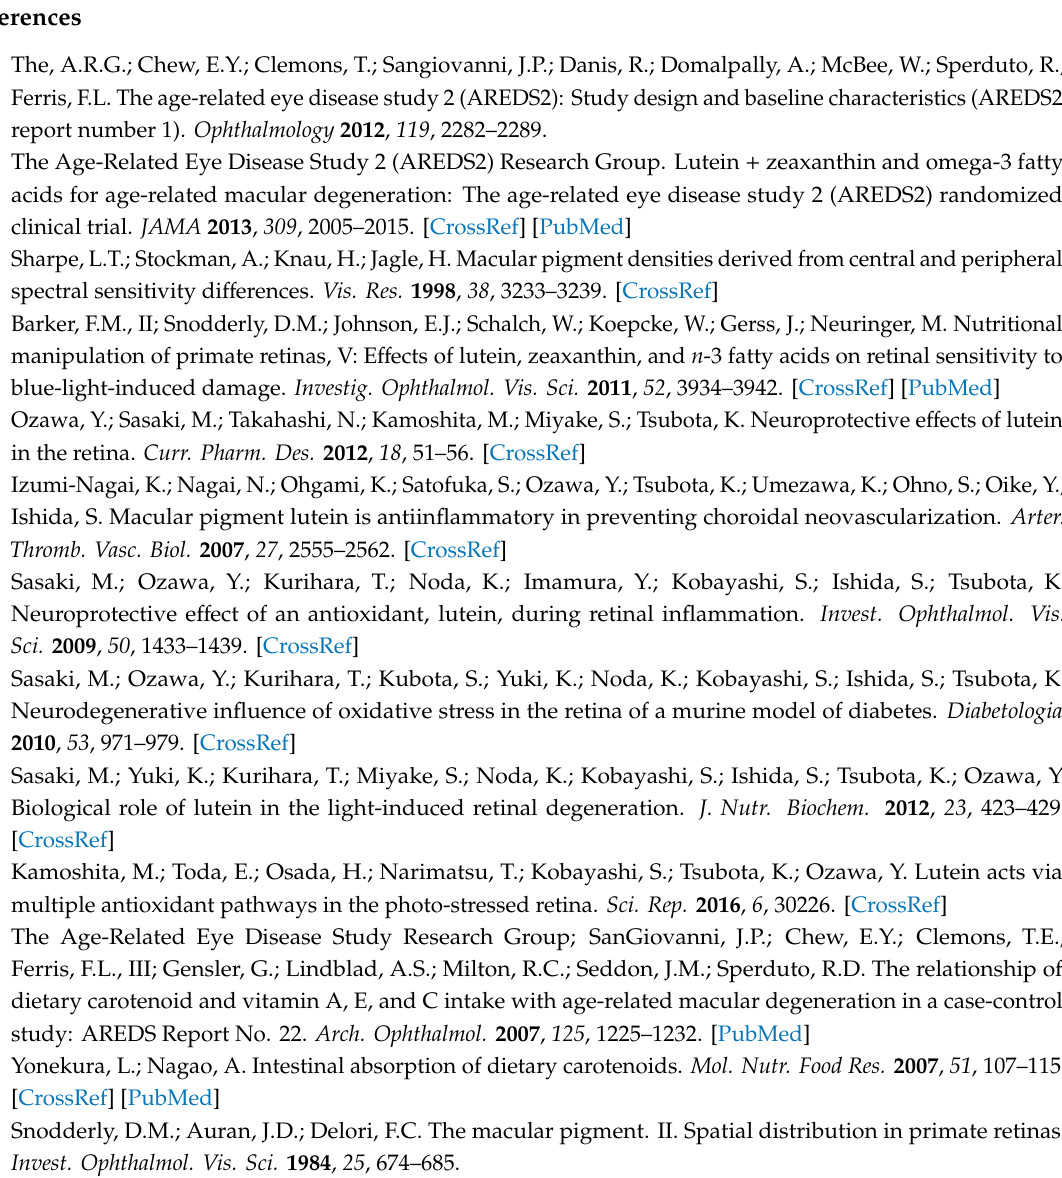
Figure S1: Correlations between MPOD and CRT, foveal, parafoveal, and macular volumes, and GCL, IPL, and ONL volumes of the macular area from the dataset of right eyes which did not have high myopia together with those of the left eye in subjects who had high myopia in the right eye but not in the left